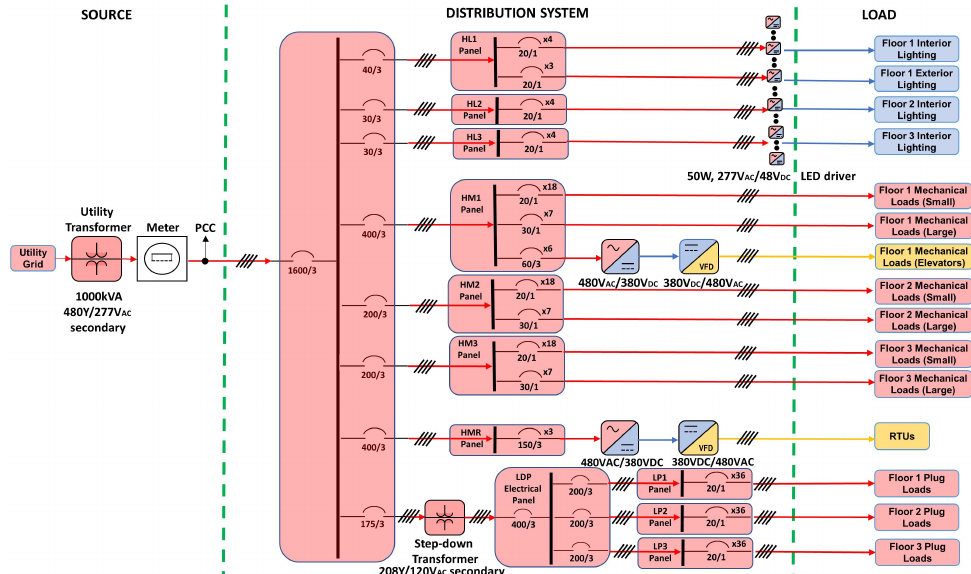
Figure 3. Modified AC electrical distribution system